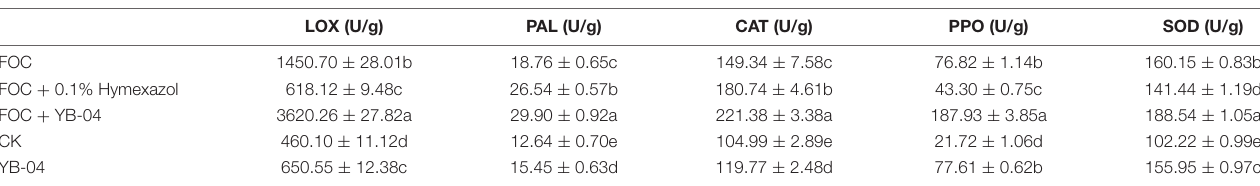
TABLE 3 | Five defense enzyme activities of cucumber leaves under different treatments.